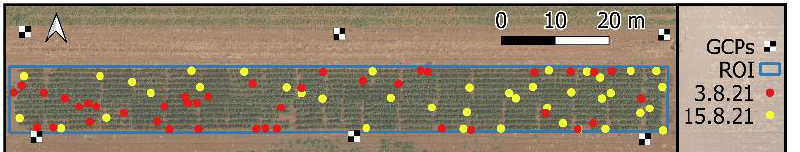
Figure 3. An example orthomosaic of the corn field in Gadash farm. The region of interest (ROI) is marked in blue, ground control points (GCPs) are marked with a checkered box, and sampling points of geo-located manual height measurements are marked with red dots for the first survey and the yellow dots for the second survey.